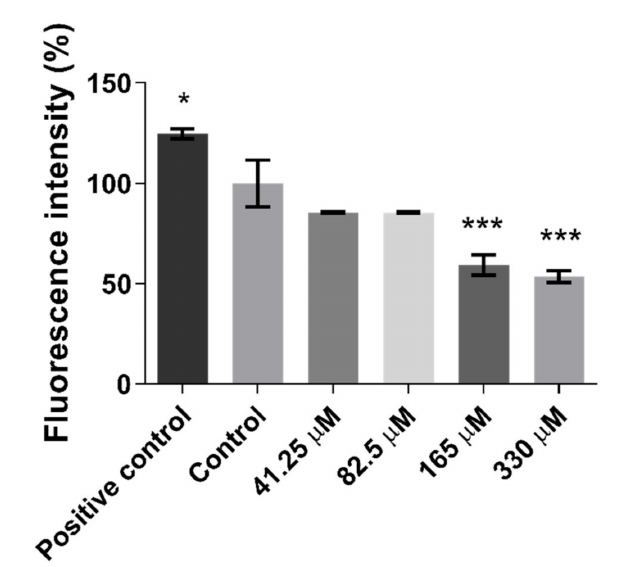
Figure 2. Effect of Quercetin on the intracellular level of Reactive Oxygen Species (ROS) in HepG2 cells. Cells were treated with Quercetin at concentration of 41.25, 82.5, 165, and 330 mM for 24 h. A two-hour pre-incubation with 500 µ M H 2 O 2 was used as a positive control. Data are expressed as a percentage of the control group ± the standard error of the mean of three replicates of three independent experiments. Comparisons between treatments and control groups were performed by one-way ANOVA followed by Dunnett post-hoc correction; * p < 0.05; *** p <